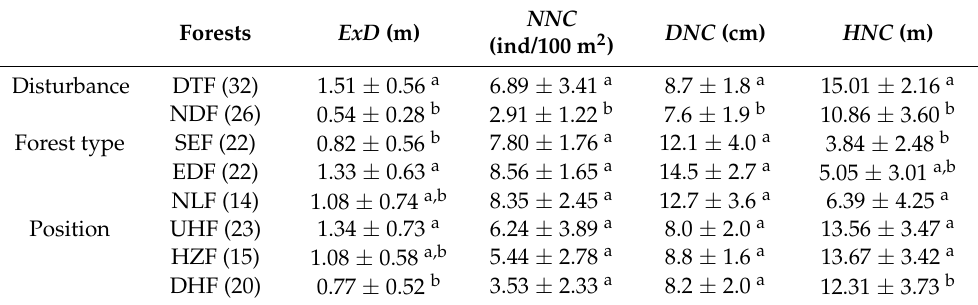
Table 3. Statistics of expansion variables of moso bamboo in the different disturbances, forest types and